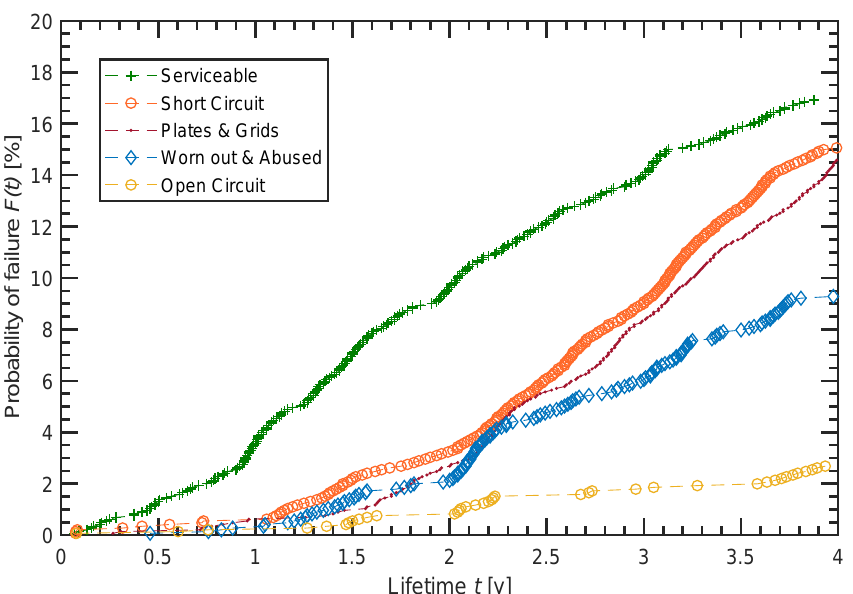
Figure 2. The major five failure modes found by BCI are shown for the total sample. The individual probability of failures F(t) is displayed for a time period of 4 years